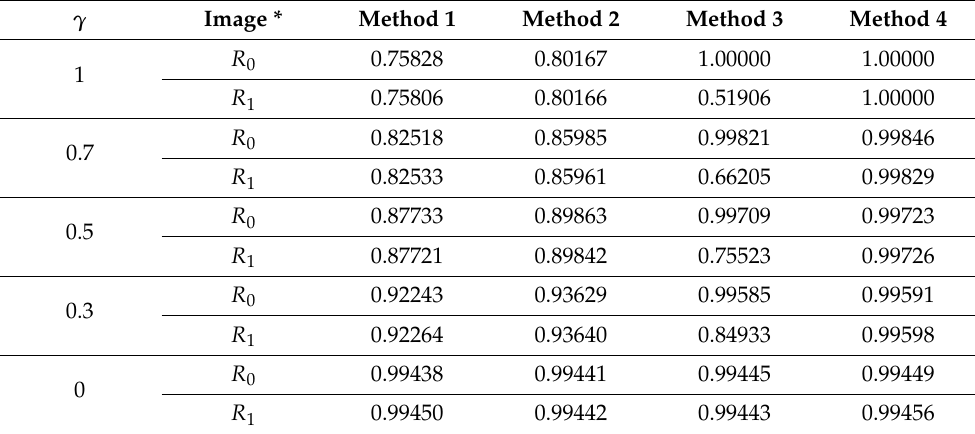
Table 4. The Sensitivity analysis of the proposed